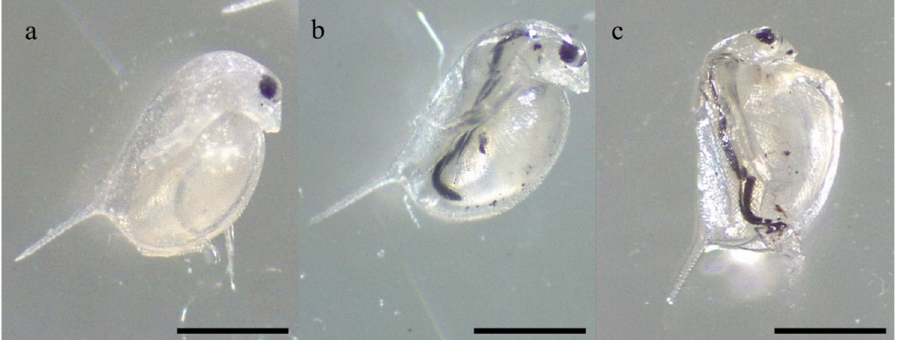
Figure 11. individuals of D. magna showing their digestive tract full of HNT ( a ), Fe 3 O 4 ( b ), and HNT/Fe 3 O 4 -C ( c ) after 48 h of exposure to 0.2 g L − 1 (10 mg/50 mL) for each material. Scale bar = 500 µm.